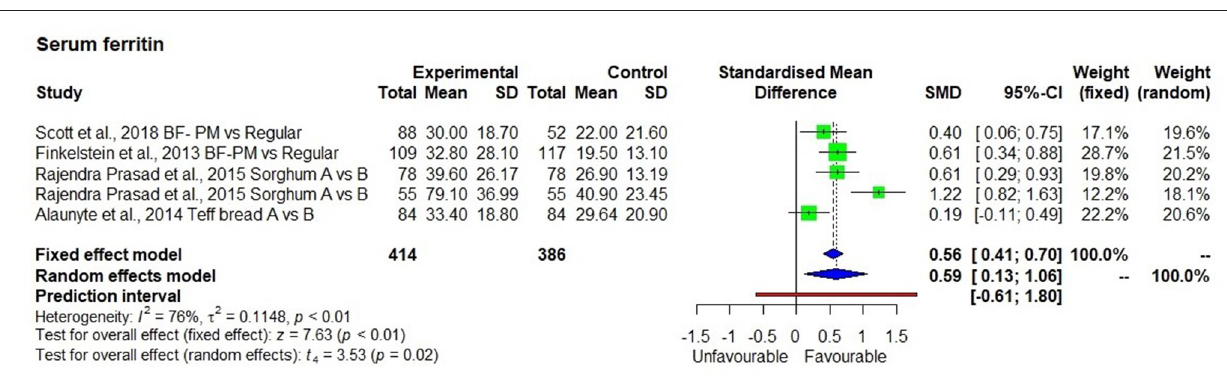
FIGURE 4 | Effect of consuming millet based meal on serum ferritin level.